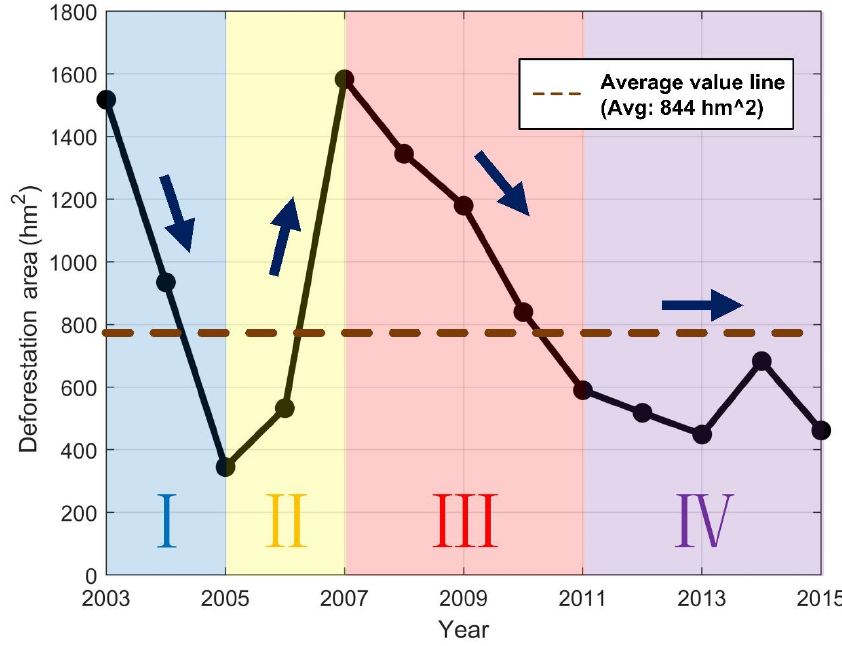
Figure 3. Variation in annual deforestation in upland Myanmar from 2003 to 2015, with the average value on the brown line. The division was divided into four stages based on four change trends.